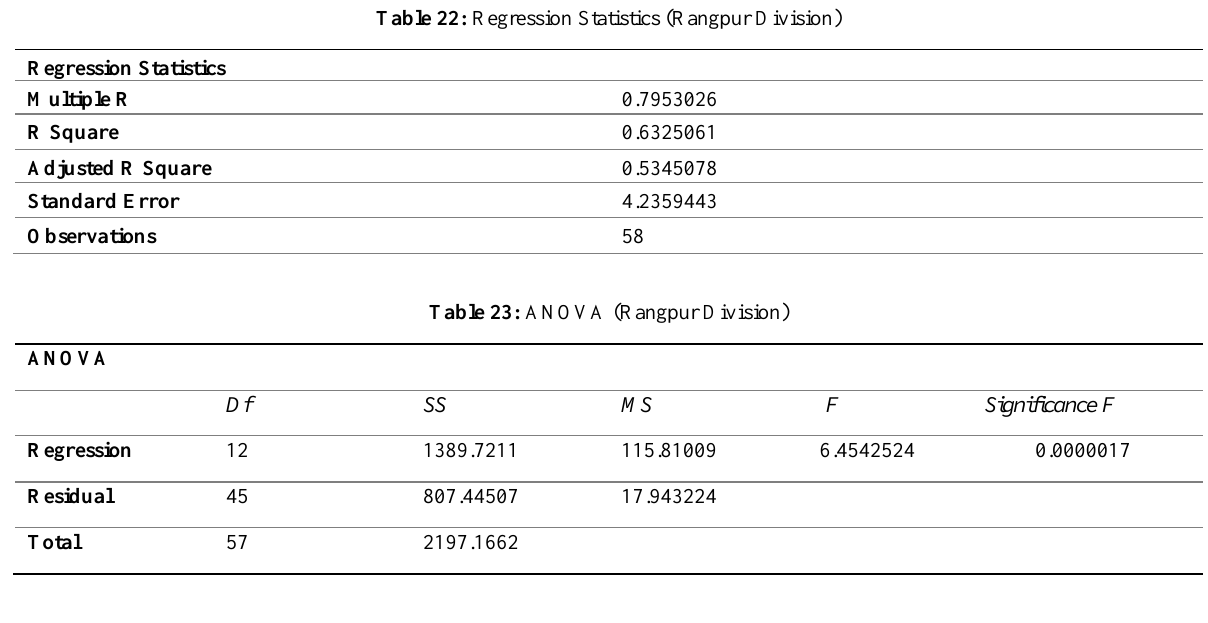
Table 24: Coefficients (Rangpur